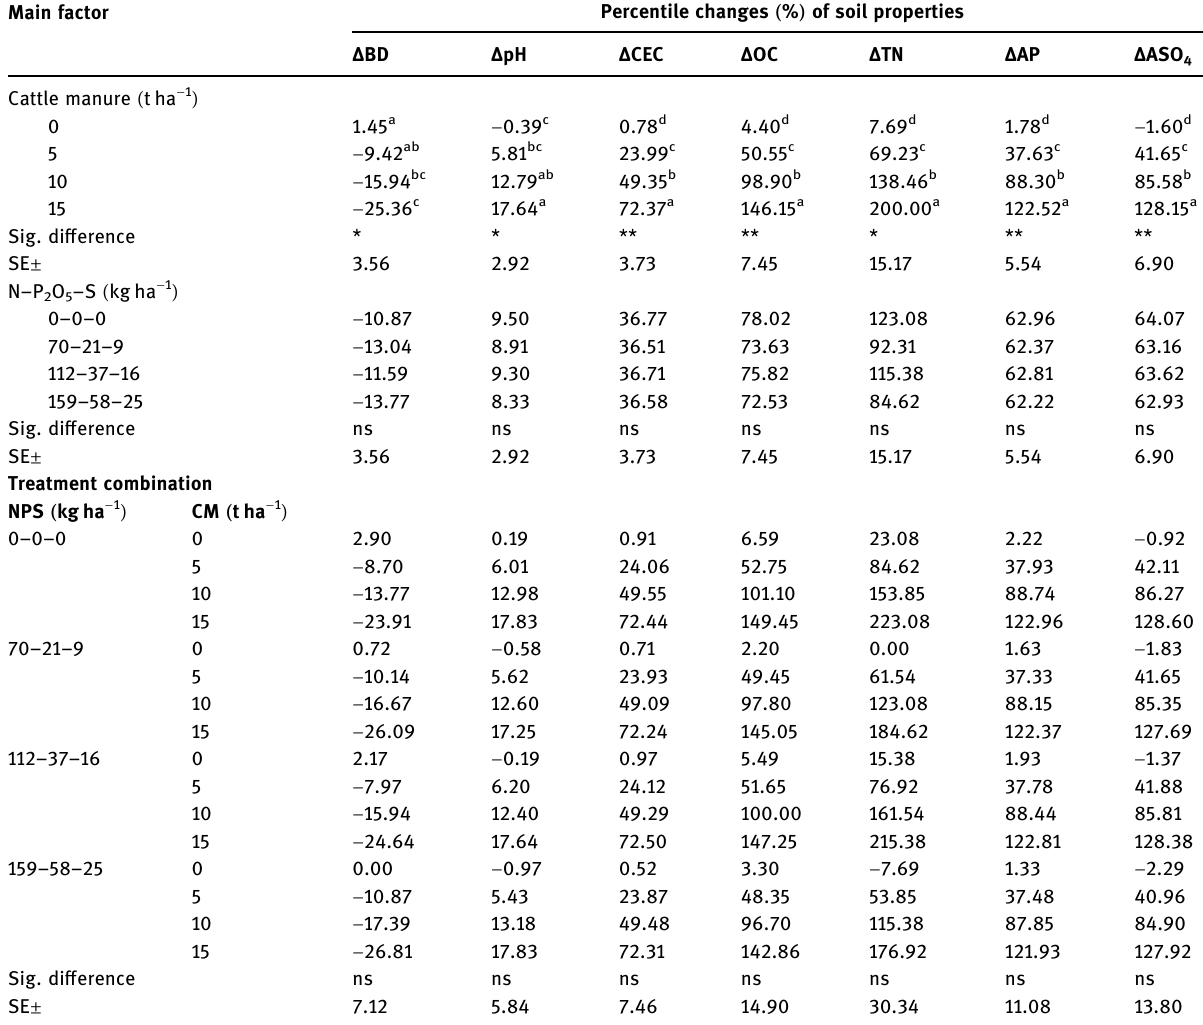
Table 4: Percentile changes of physicochemical properties of the experimental soil after two - year applications of NPS inorganic fertilizers and cattle manure to garlic